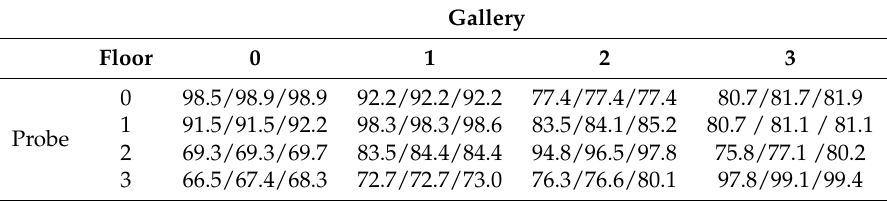
Table 3. Rank-1, Rank-5, and Rank-10 scores for each floor compared to other floors.